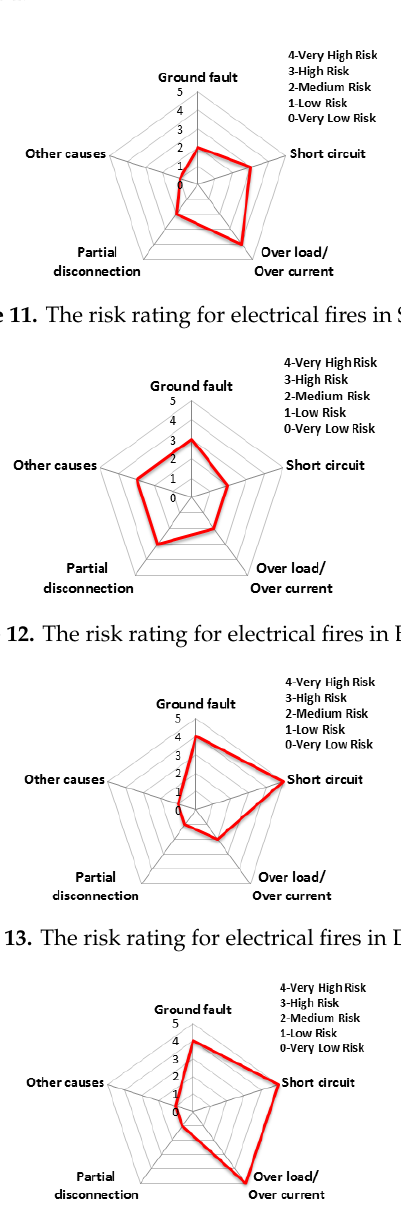
Figure 14. The risk rating for electrical fires in Daejeon.